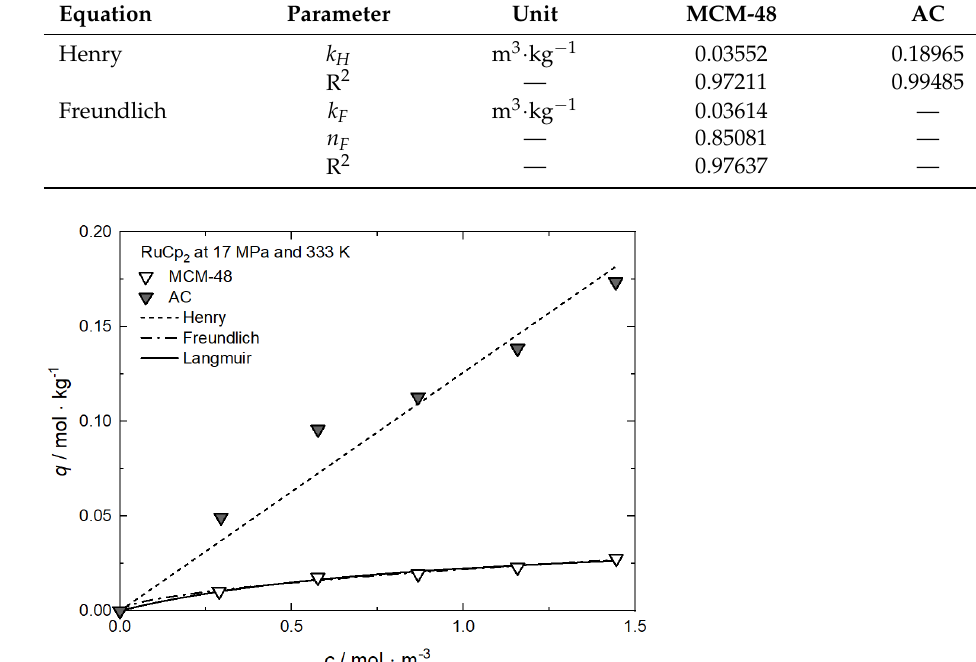
— Figure A16. Uptake of Pt(cod)me 2 at 10.6/10.7 MPa and 308 K on different substrates; experimental data taken from [10,58].